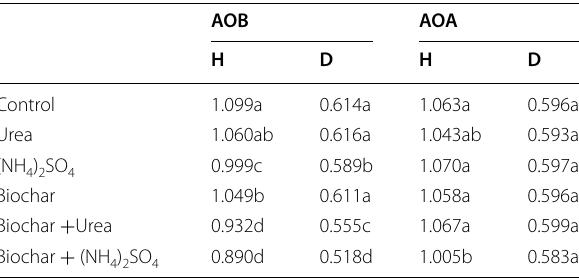
Different letters indicate significance at p <